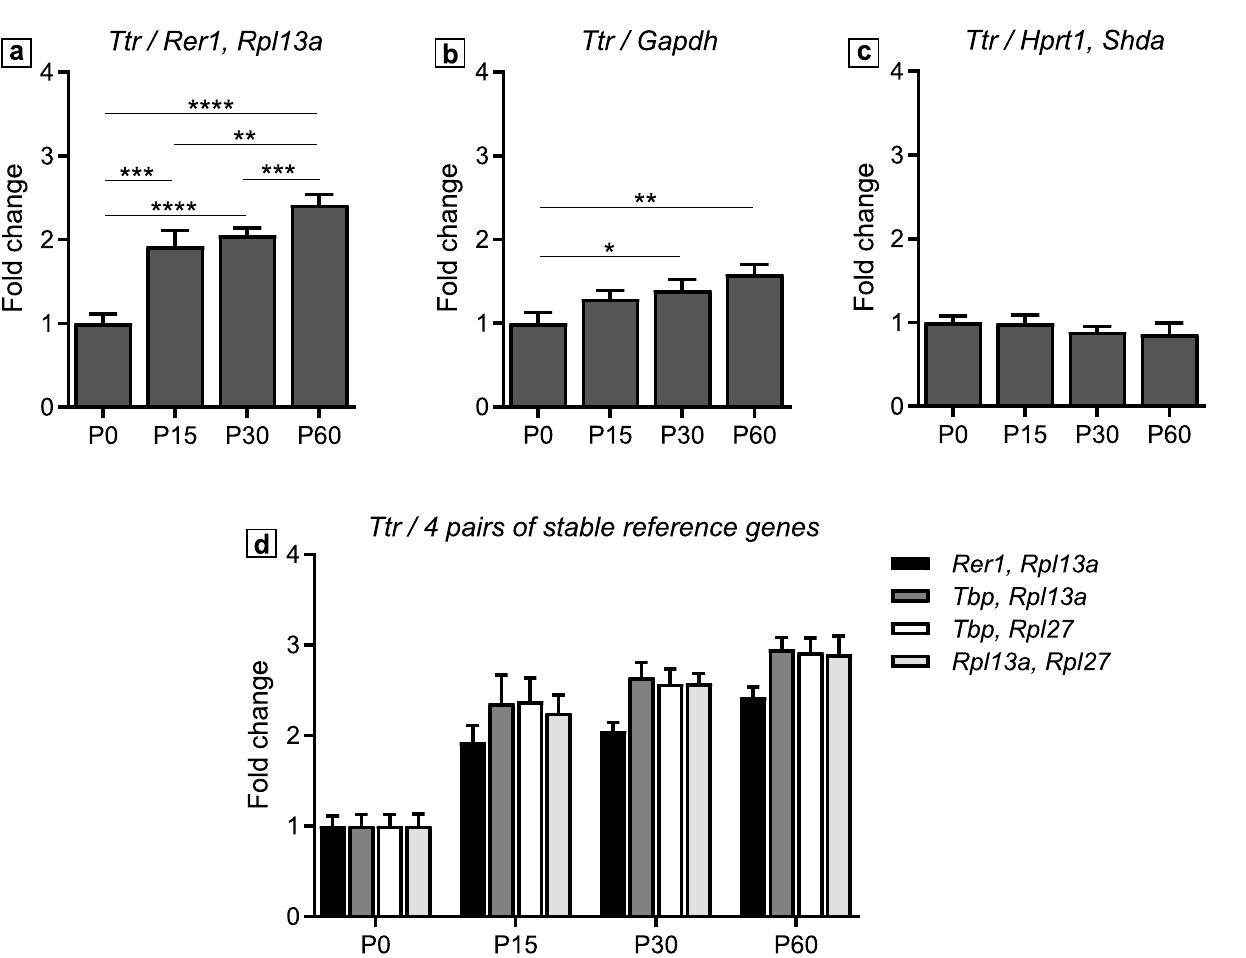
Figure 5. Relative expression of Ttr normalised to different reference genes. Ttr relative expression compared to the most stable reference genes in the Developmental panel: Rer1, Rpl13a ( a ); to Gapdh ( b ) and to the least stable genes in the Developmental panel: Sdha, Hprt1 ( c ). Ttr relative expression normalized to Rer1, Rpl13a versus different combination of the 3 common stable genes Tbp, Rpl13a, Rpl27 ( d ). Data is presented as Mean ± SD, adjusted p-values are indicated as * p ≤ 0.05, ** p ≤ 0.01, *** p ≤ 0.001, **** p ≤